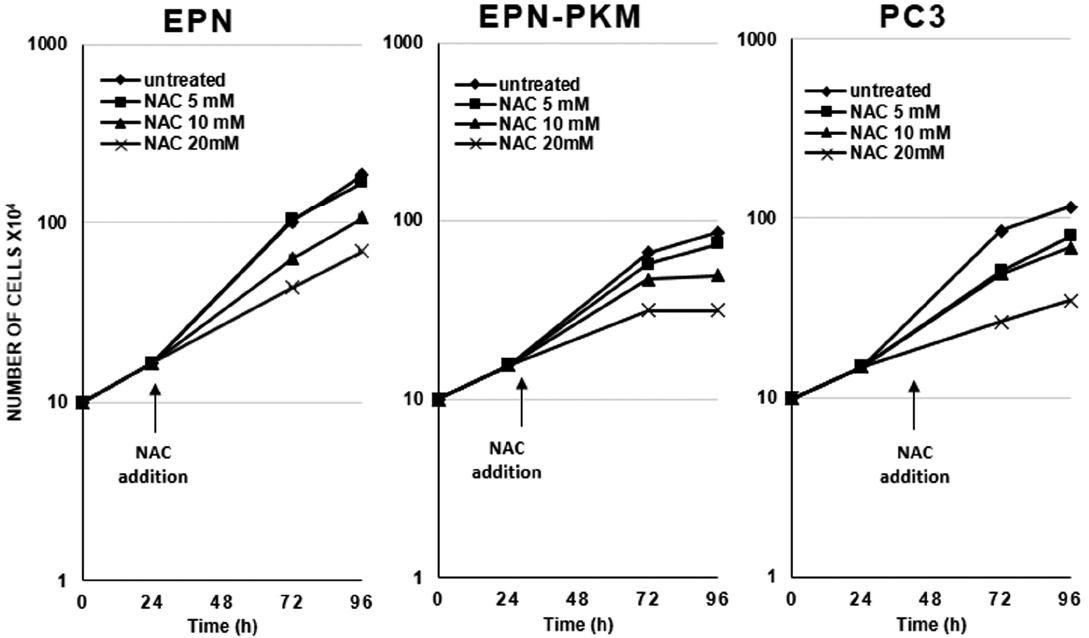
Figure A1. The effect of NAC on the proliferation of EPN, EPN-PKM and PC3 cells NAC (5, 10 and 20 mM) was added 24 h after seeding 1 × 10 5 EPN, EPN-PKM and PC3 cells in standard medium. Cell number was determined in a Neubauer hemocytometer at the indicated time points. Data are mean ± SD of a representative experiment performed in triplicate. Table A1. Statistical analysis was performed by Anova followed by Bonferroni post-test, as shown in table. (***) indicates statistically significant differences ( p < 0.001).